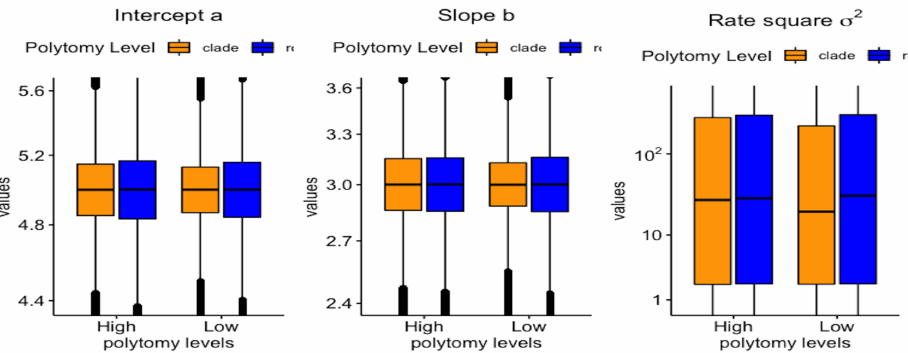
Figure 8. Boxplots for the intercept a , the slope b , and the square of rate of evolution σ 2 with varying polytomy type and